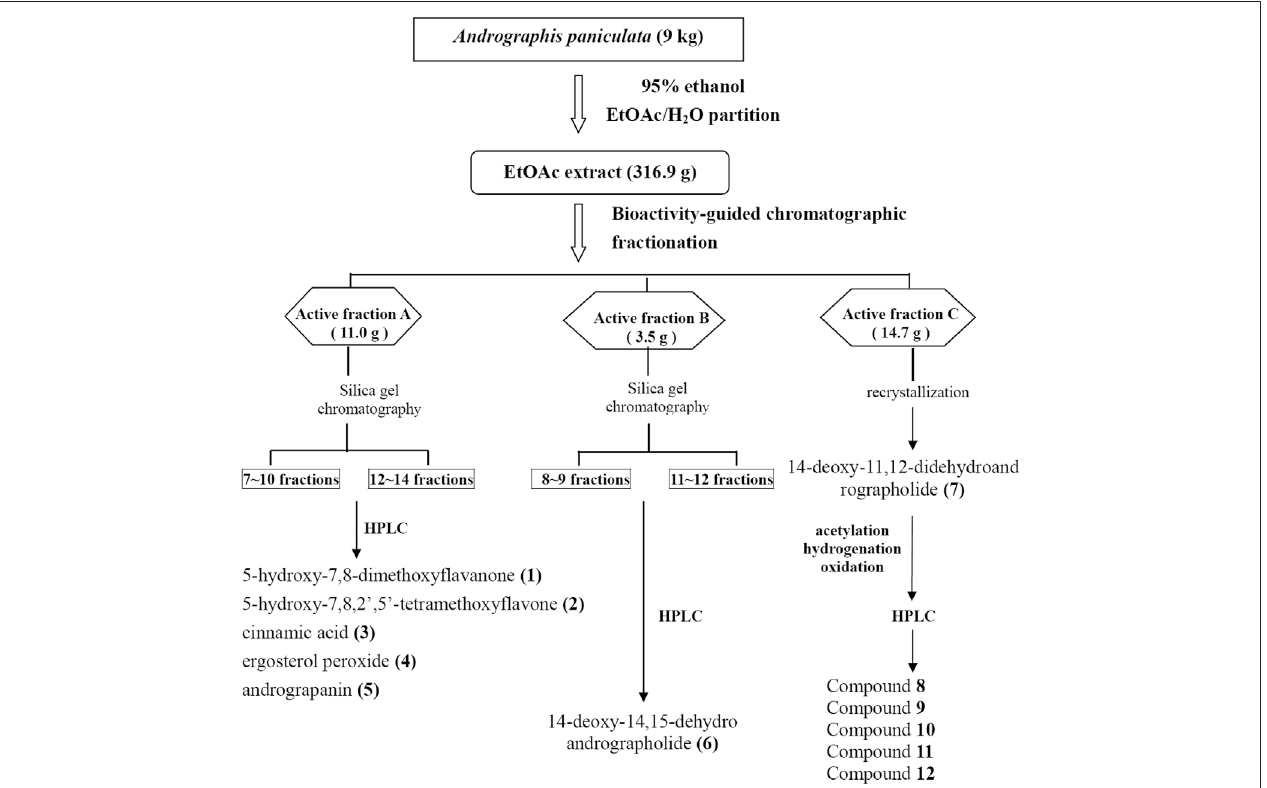
FIGURE 1 | The extraction procedure for the separation and identi fi cation of Andrographis paniculata EtOAc extract. Compounds tested for anti-EV71-induced cytotoxicity are enumerated with Arabic numbers (bold). EtOAc, ethyl acetate; EV71, enterovirus 71.